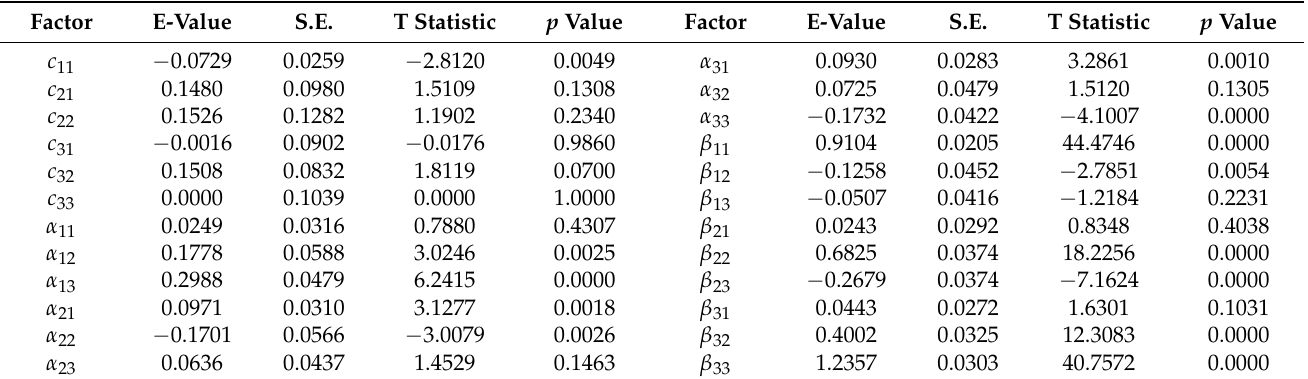
Table 11. BEKK variance equation estimation results in the second stage.